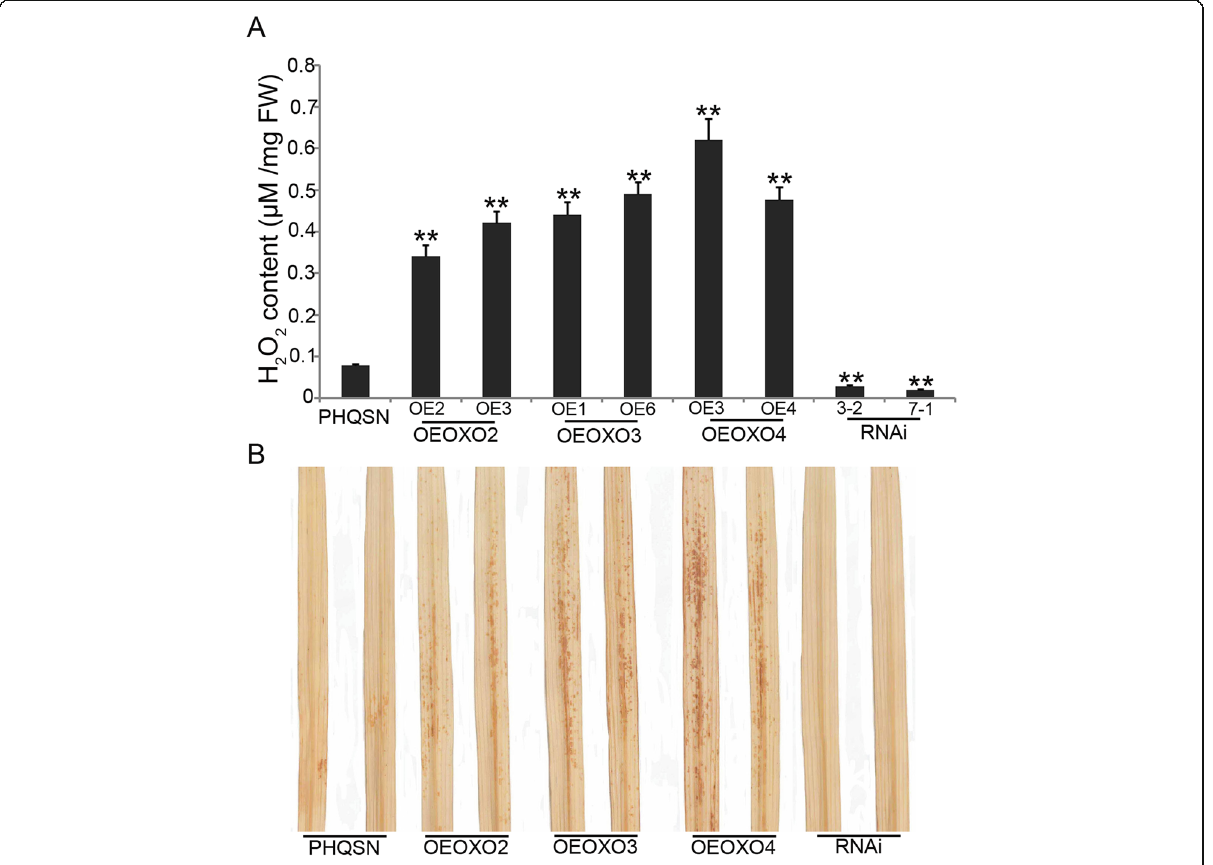
Fig. 5 Hydrogen peroxide (H 2 O 2 ) contents in the OXO transgenic plants and control plants. a H 2 O 2 contents in the panicles of PHQSN, OEOXO2, OEOXO3, OEOXO4 and RNAi plants. b DAB staining of the leaves for PHQSN, OEOXO2, OEOXO3, OEOXO4 and RNAi plants. Error bars indicate the SD of at least ten biological replicates and ** indicates significant differences between the transgenic and control plants ( t test, P < 0.01). FW means fresh